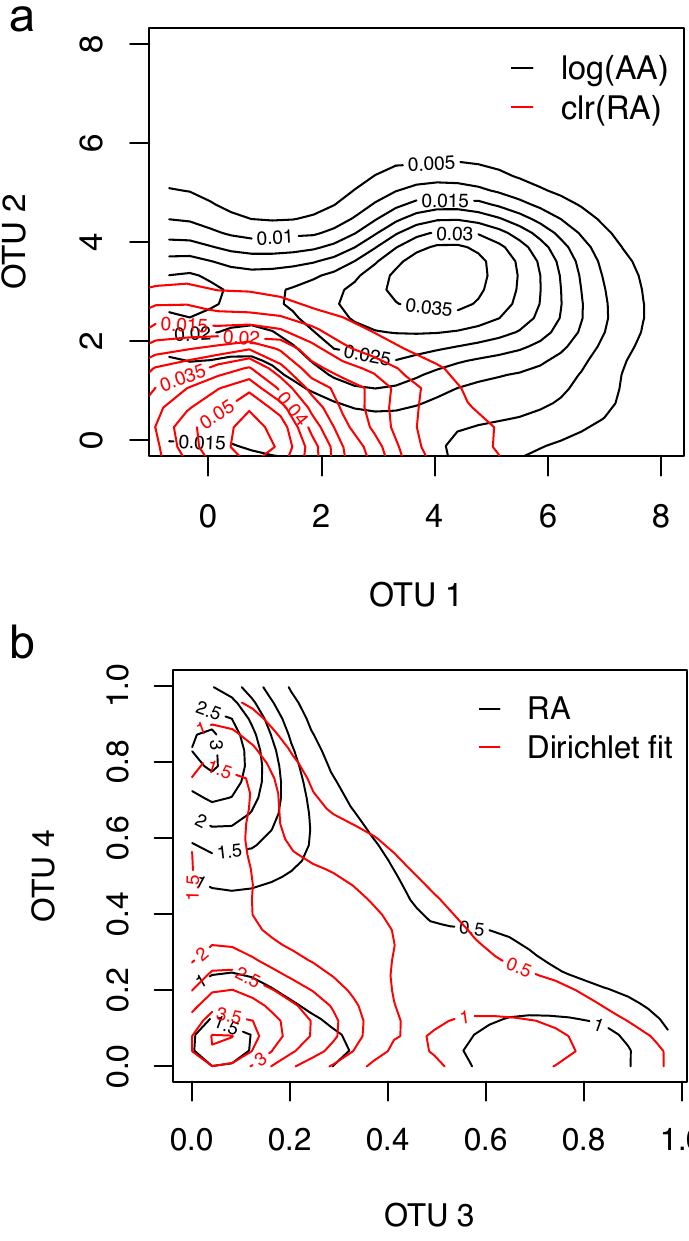
Figure 1. The contour plots of Faecalibacterium (OTU1) and Bacteroides (OTU2) from AGP in the upper panel and taxa Clostridium (OTU3) and Escherichia (OTU4) on the lower panel. In ( a ), AA is the absolute abundance that describes the OTU counts for taxa. The black lines are the estimated contour plots of samples, and the red lines are the contour plots of estimated distributions, which shows that there are large departures between the estimated contour plots of samples and the contour plots based on the estimated normal distribution with CLR ( a ) or the estimated Dirichlet distribution ( b